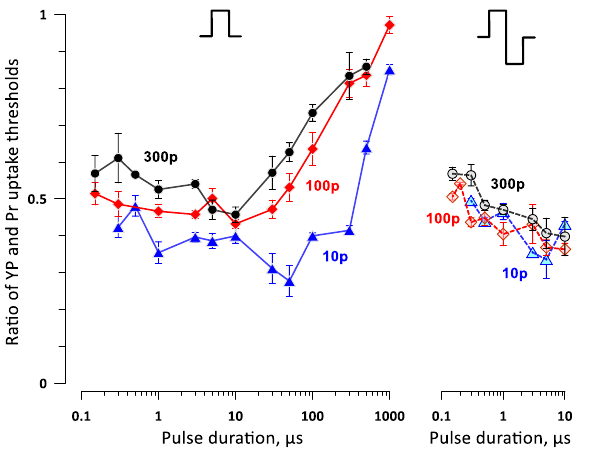
Figure 12. The ratios of electric field strengths thresholds for reversible and irreversible electroporation (cell death) at different pulse durations. For clarity, the ratios were plotted separately for trains of unipolar and bipolar pulses (left and right panels). Labels “10p”, “100p”, and “300p” stand for trains of 10, 100, and 300 pulses, respectively. See Fig. 11 and text for more